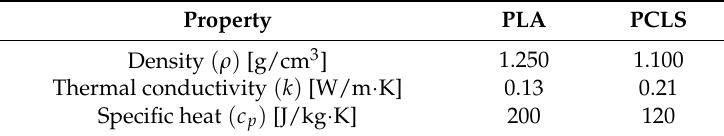
Table 5. Thermal properties of the biopolymers used in the self-adhesion